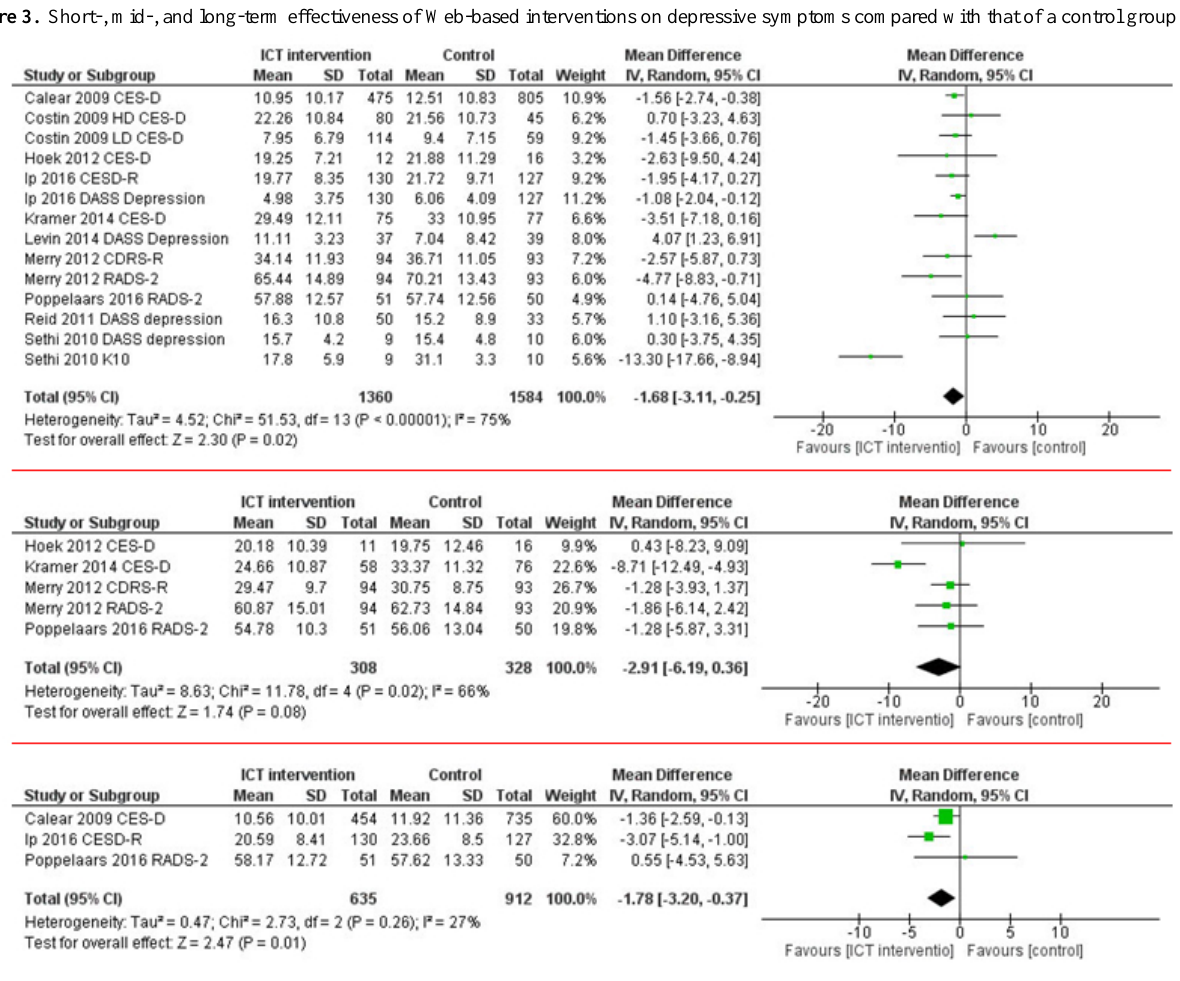
Figure 3. Short-, mid-, and long-term effectiveness of Web-based interventions on depressive symptoms compared with that of a control group.